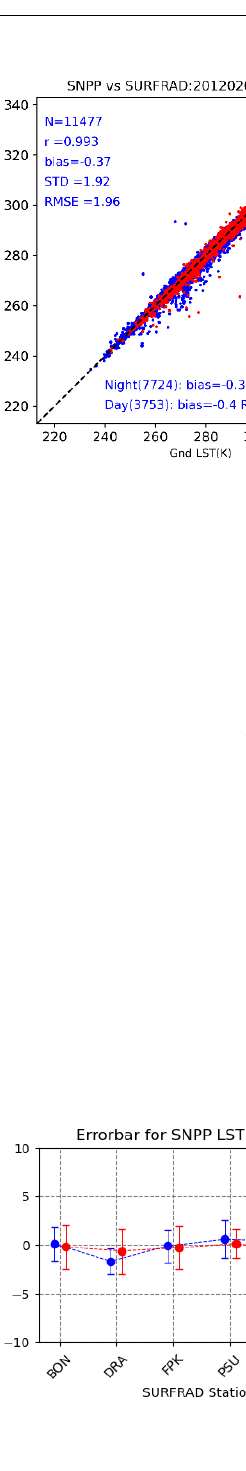
Figure 3. Time series plots of SNPP VIIRS LST errors in each SURFRAD station from 2012 to 2022 (blue color for nighttime and red color for daytime). The top right plot shows the time series over the DRA site. It indicates a strong sea- sonal cycle in the difference, which was not so pronounced prior to the year 2017. The discrepancy increased over time, particularly after 2018, when the SNPP and NOAA-20 coexist, which explains the cause of the large negative bias exhibited in the NOAA-20 LST. Li et al. [19] also reported a strong seasonal cycle over the DRA site, with ten years of MODIS data from 2002 to 2012, but to a lesser extent. A large negative bias over the DRA site was observed and the surface emissivity in the MYD11A product is on average 0.98 [19]. A significant negative bias was also reported in the MODIS LST validation at the four barren surface sites attributed to the overestimated emissivity in arid and semi-arid re- gions [39]. The ASTER Global Emissivity Dataset (GED), a mean emissivity database, is used as the data source for the emissivity climatology over the bare ground in the NOAA LSE product. It is reported that ASTER GED can improve the accuracy of SW LST over a barren surface for MODIS data [40]. Figure 4 indicates the mean emissivity of 0.967 com- pared to 0.98 for MODIS. Therefore, less impact is expected from the NOAA LSE input on the LST underestimation.